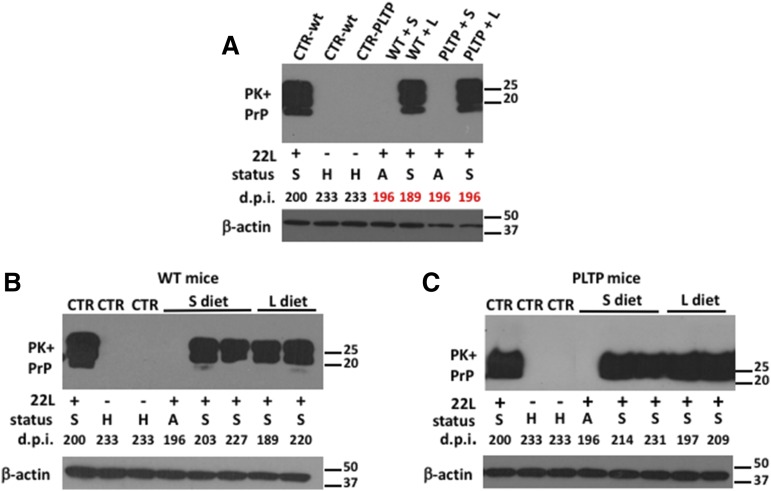
Detection of the pathologic PrPSC marker in brain homogenates of asymptomatic and sick mice. A–C: Brain homogenates of WT or PLTP−/− mice, inoculated (+) or not (−) with 22L prion strain and fed a standard chow diet (+S) or Western-type cholesterol-rich diet (+L) were analyzed by immunoblotting after PK digestion (PK+). The numbers below each panel indicate the day when the mice were euthanized (dpi). The letters below each panel (S, sick; H, healthy; A, asymptomatic) indicate the status of the mice when they were euthanized. PrP means that the immunoblots were probed with SAF84 anti-PrP antibodies. Loading control blots, performed on the identical samples before PK digestion were probed with anti-β-actin antibodies. The molecular weight markers are indicated on the right side of each immunoblot.